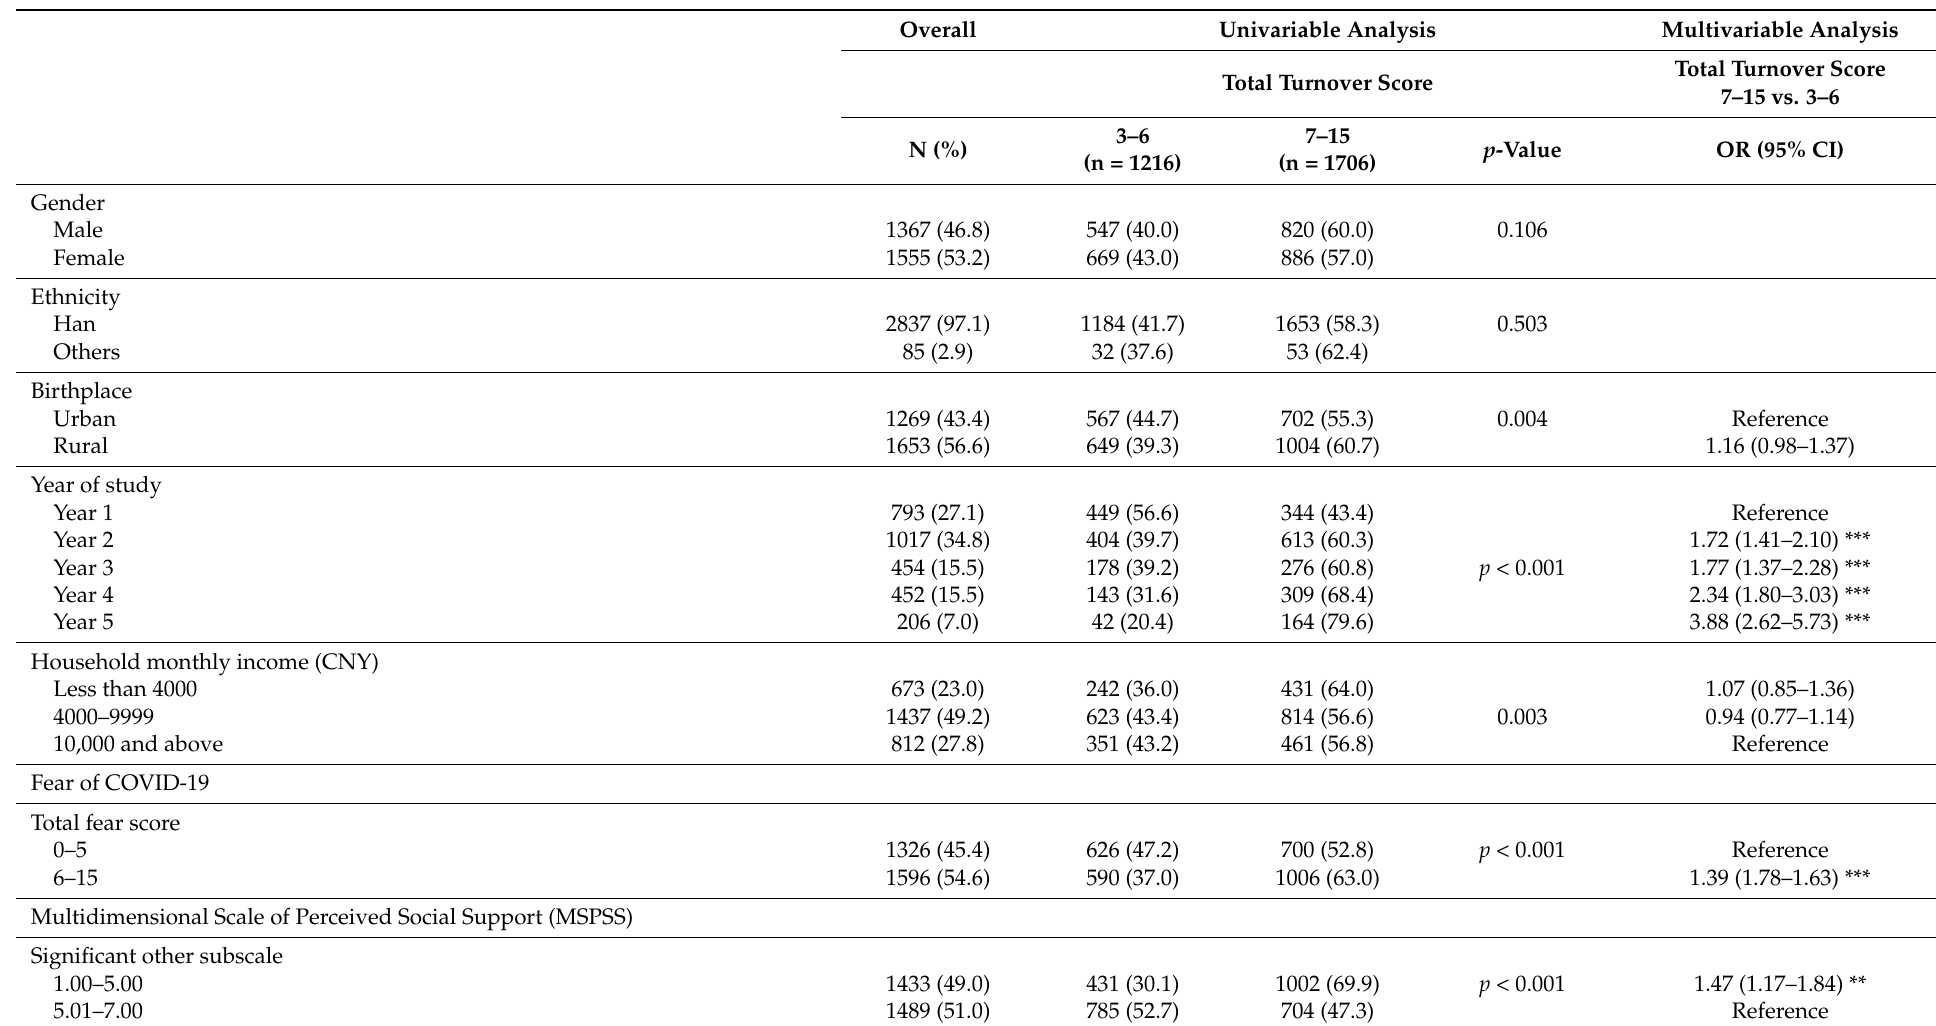
Table 1. Demographics of participants and factors associated with total turnover score (N =